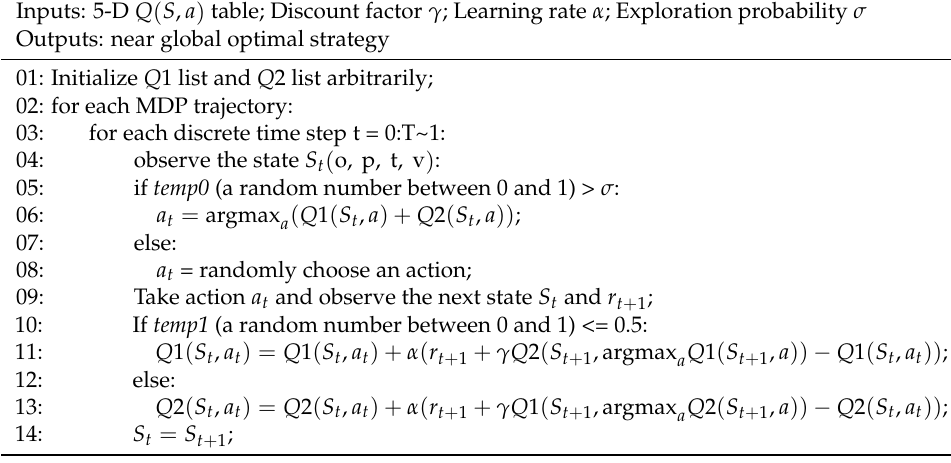
Table 2. Pseudo code of the original double Q learning algorithm.